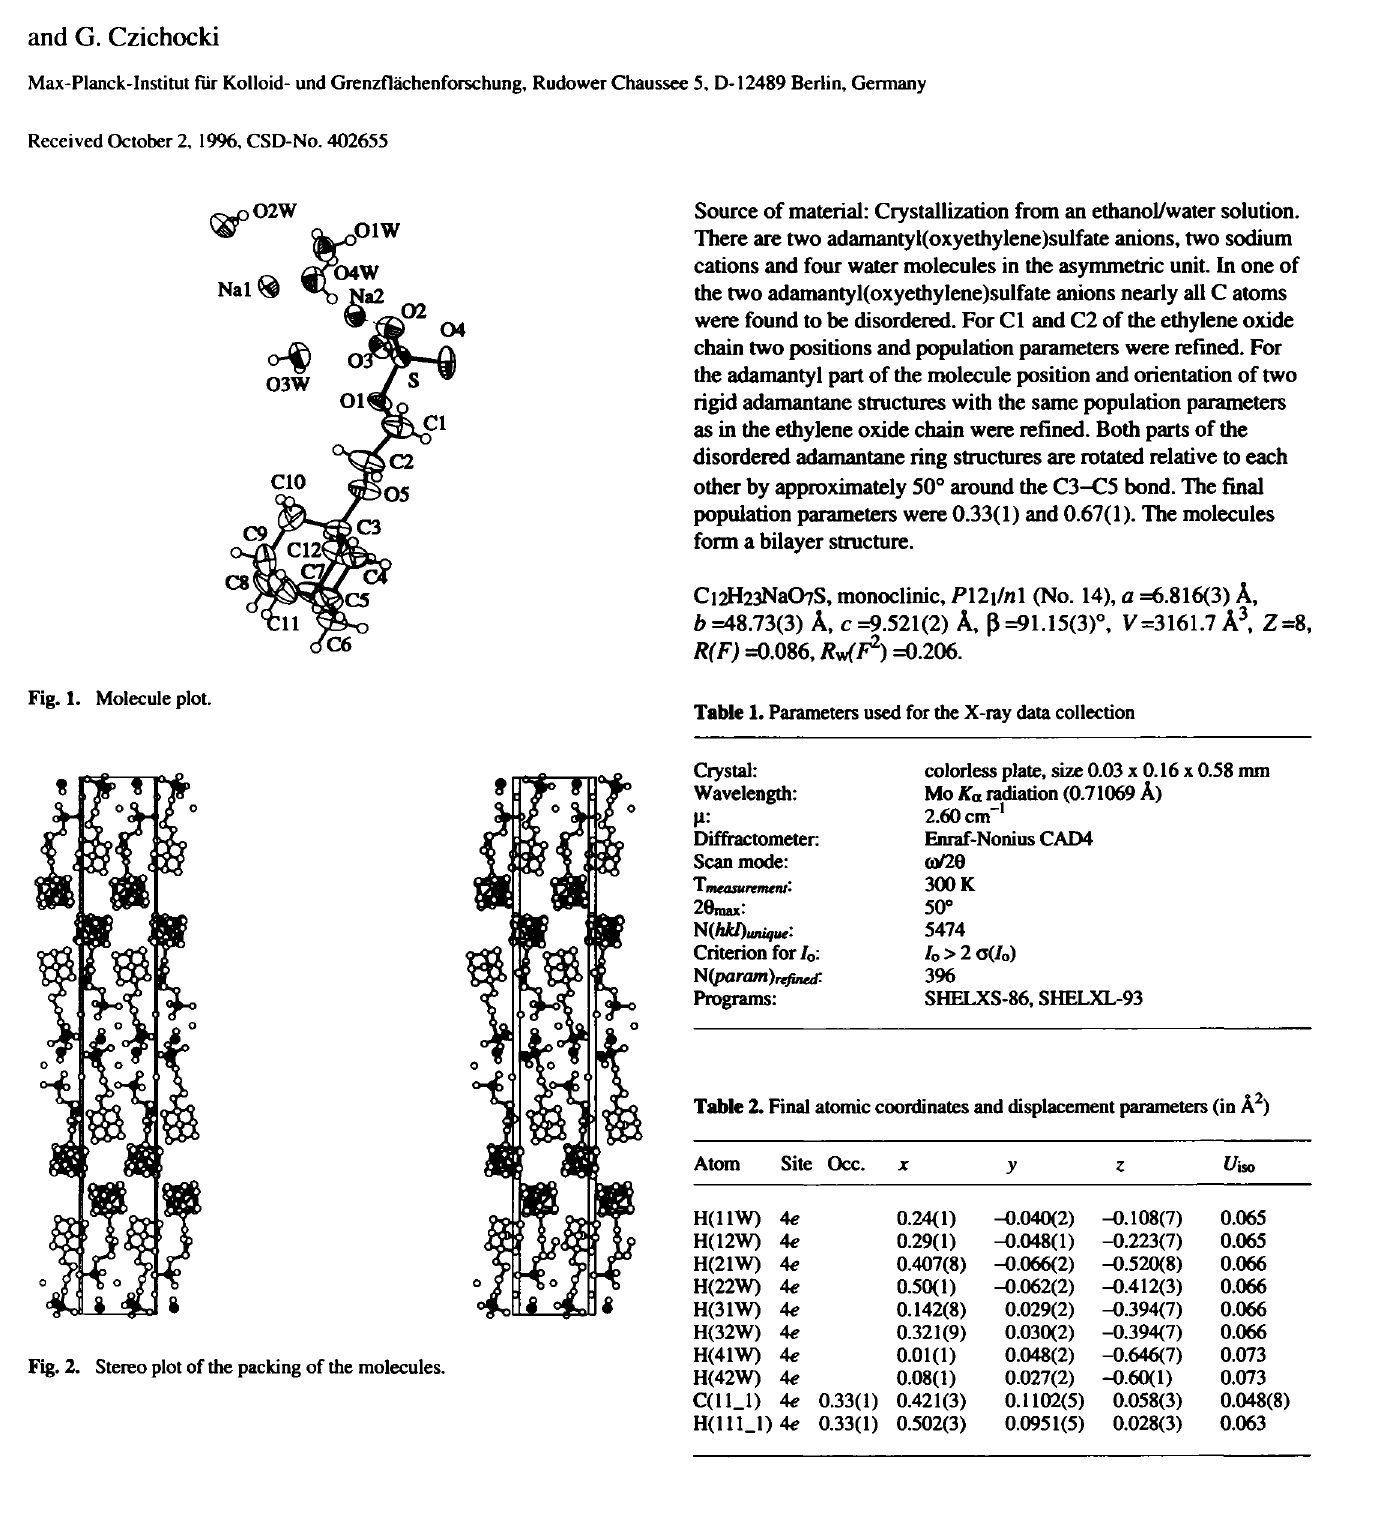
Fig. 2. Stereo plot of the packing of the molecules.